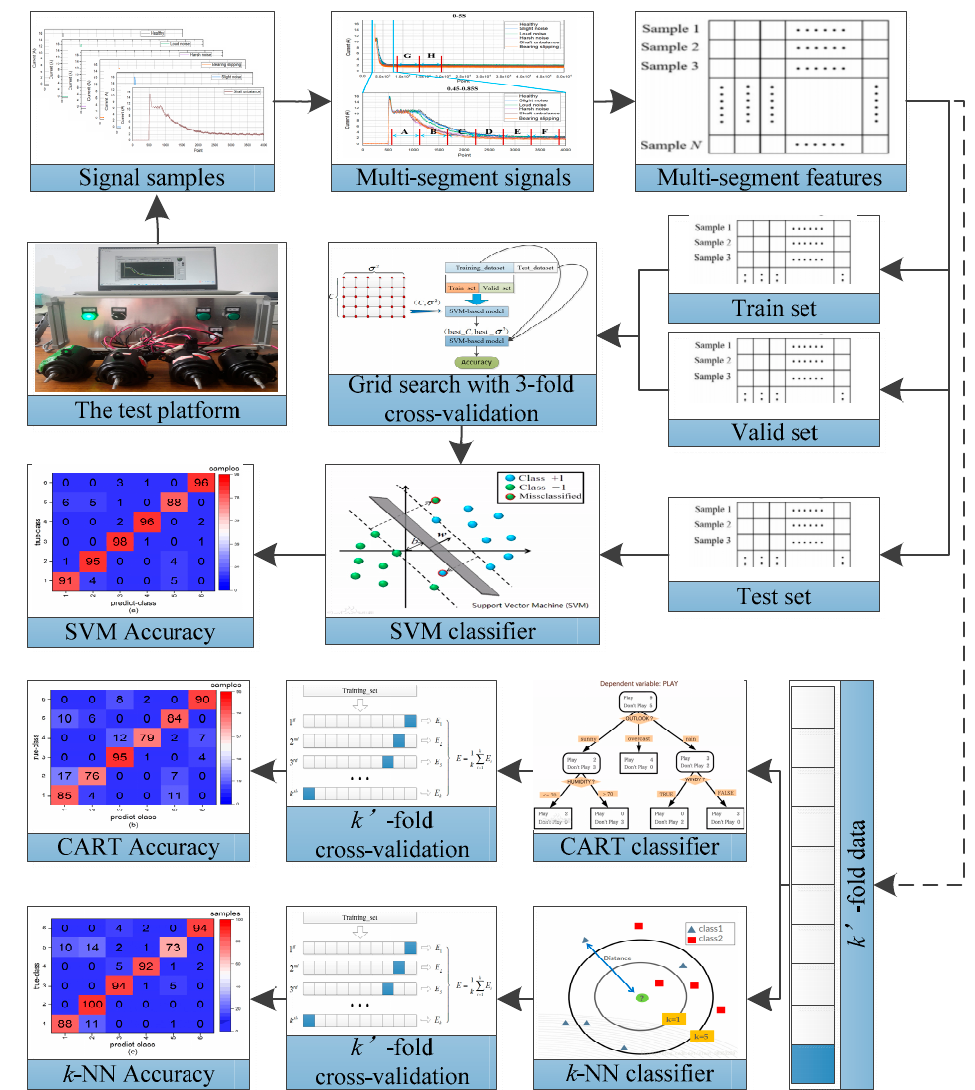
Figure 3. Fault diagnosis procedure of PMDCMs based on the SVM, CART, and k -NN by multi-segment features.